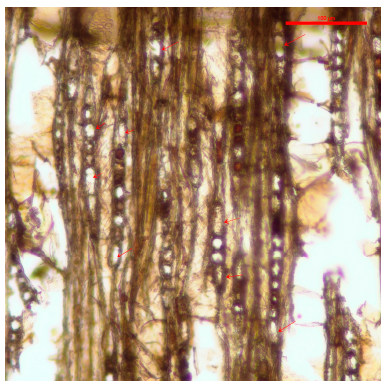
Figure 2. Tangential section of a willow with arrows pointing to the upright ray cells. All rays are uniseriate. Magnification 200×.